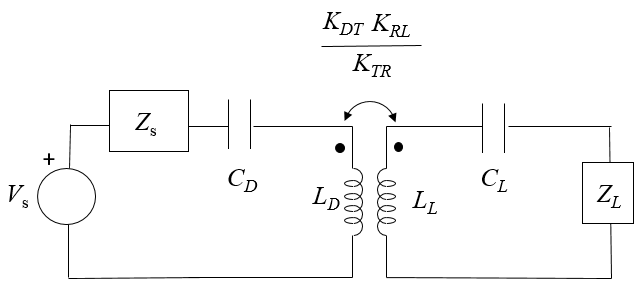
Figure 4. Model of a four-coil scheme as a two-coupled coil scheme operating at resonance.